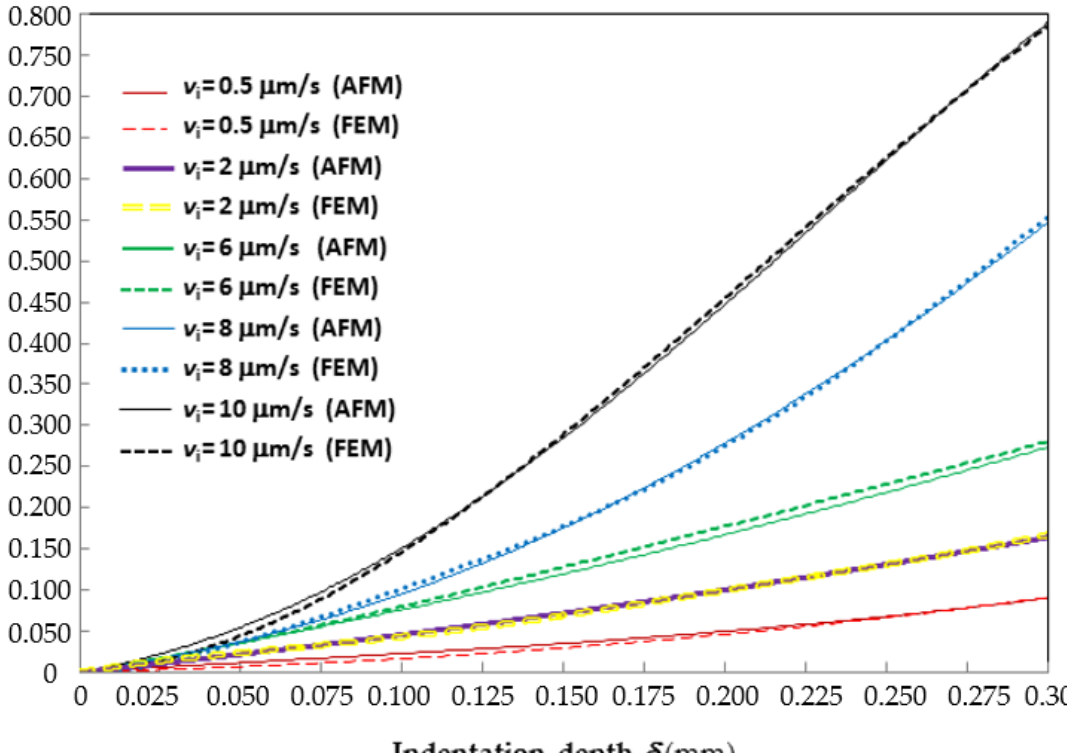
Figure 2. Comparison of representative experimental force–indentation curves with those reconstructed via inverse analysis for different indentation rates.